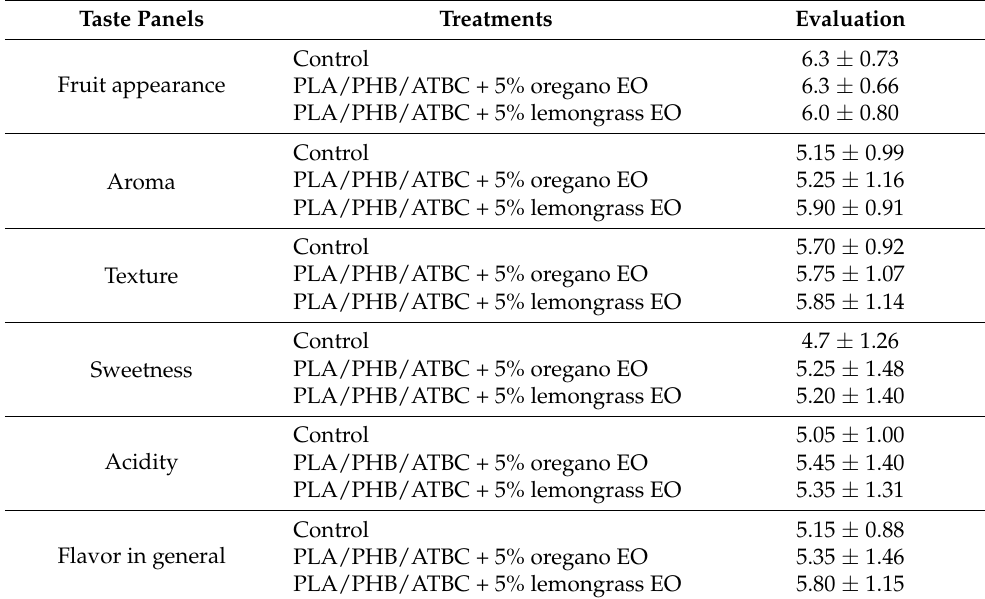
Table 3. Sensory evaluation of strawberries in active packaging using PLA/PHB/ATBC + 5% oregano EO and PLA/PHB/ATBC + 5% lemongrass EO after 18 days of storage. Taste Panels Treatments Evaluation Control 6.3 ± Fruit appearance